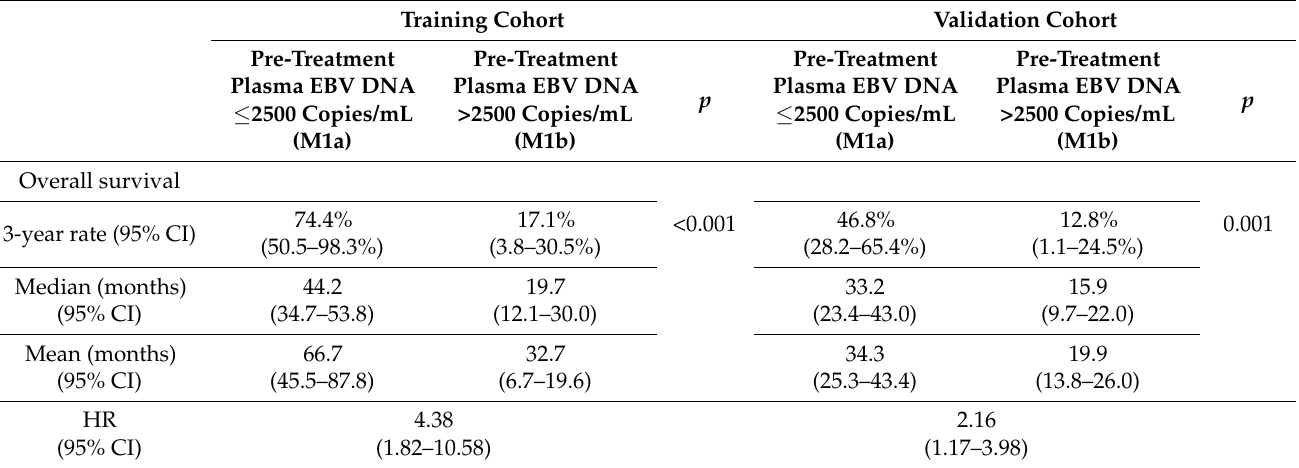
M1b categories stratified by the pre-treatment plasma EBV DNA >2500 copies/mL in prognostic-RPA groups derived in Set 2 RPA in the training cohort, ( b ) OS of patients of proposed M1a and M1b categories stratified by the pre-treatment plasma EBV DNA >2500 copies/mL in prognostic-RPA groups derived in Set 2 RPA in the validation cohort. RPA, recursive partitioning analysis; EBV DNA, Epstein–Barr virus deoxyribonucleic acid. Table 5. Overall survival of M1a (pre-treatment plasma EBV DNA ≤ 2500 copies/mL) and M1b (pre-treatment plasma EBV DNA >2500 copies/mL) derived by Set 2 RPA (prognostic-RPA groups) in training and validation